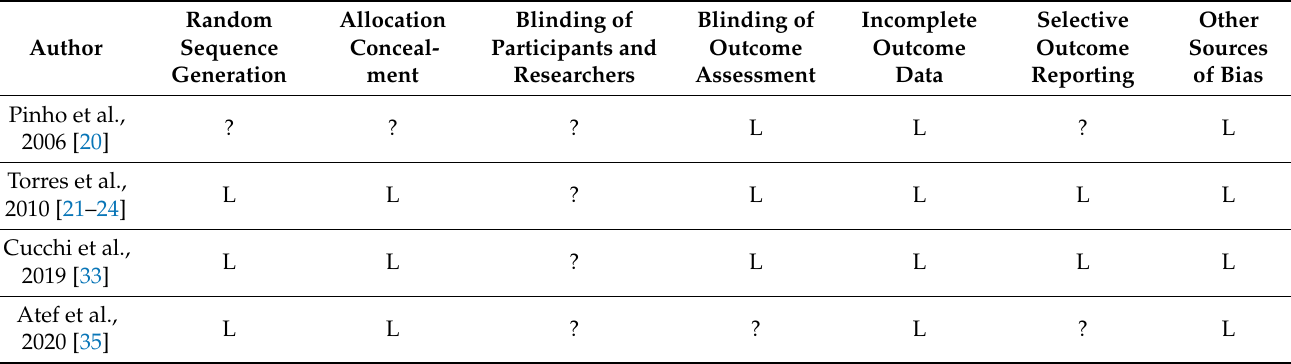
Table 2. Risk of Bias of included randomized clinical trials.